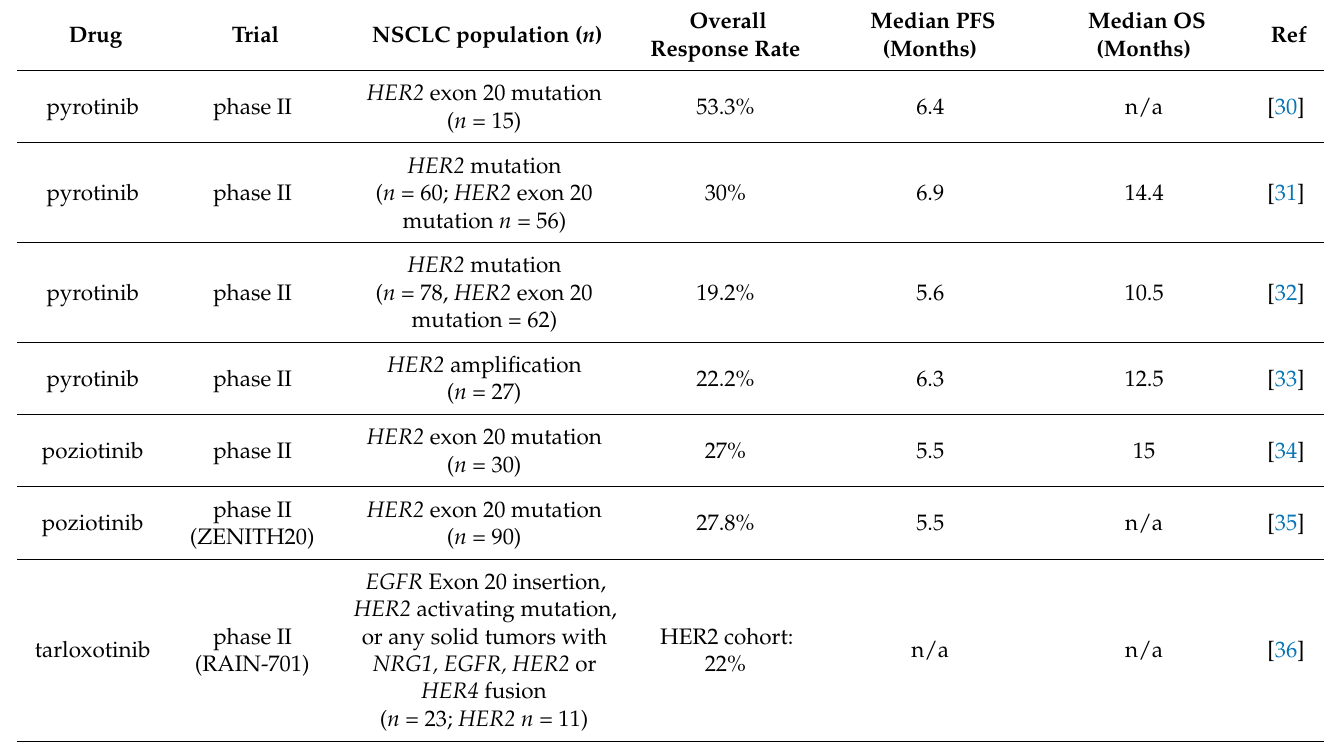
Table 3. Studies of Tyrosine Kinase Inhibitors in HER2 exon 20 mutation